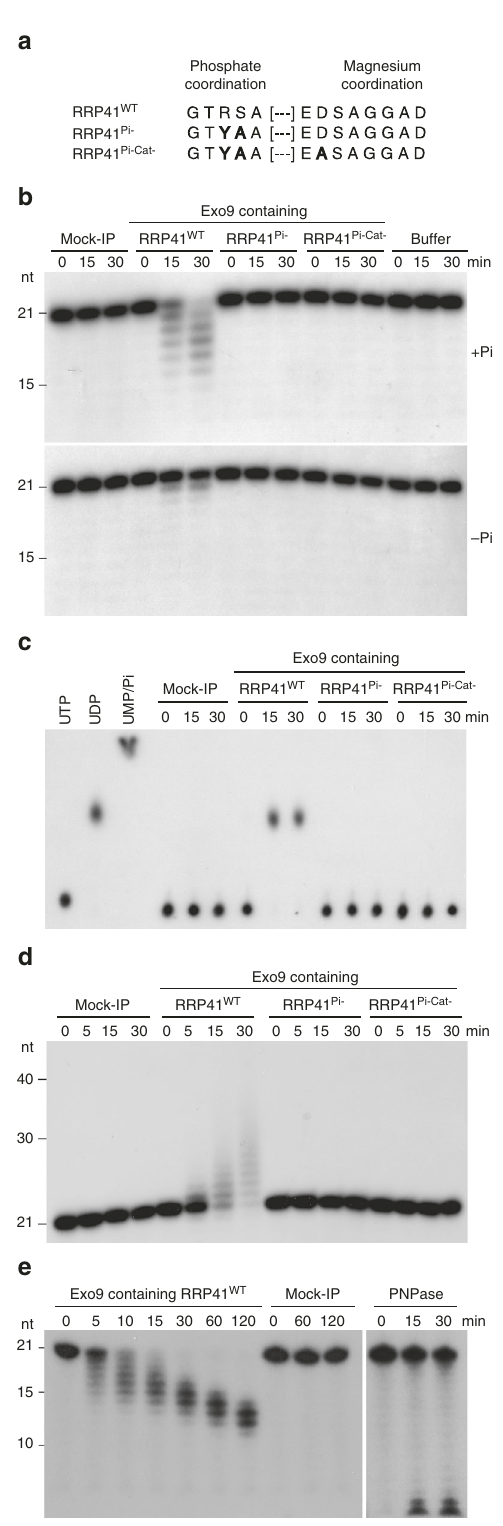
by the RRP41 subunit. a Mutations introduced to inactivate RRP41. Mutated amino acids are shown in bold. The mutated Pi coordination site and sequence found in the inactive human RRP41. b Exo9 ’ s activity is due to RRP41 and is stimulated by Pi. A 5 ′ [ 32 P]-labeled oligo(U)21 RNA